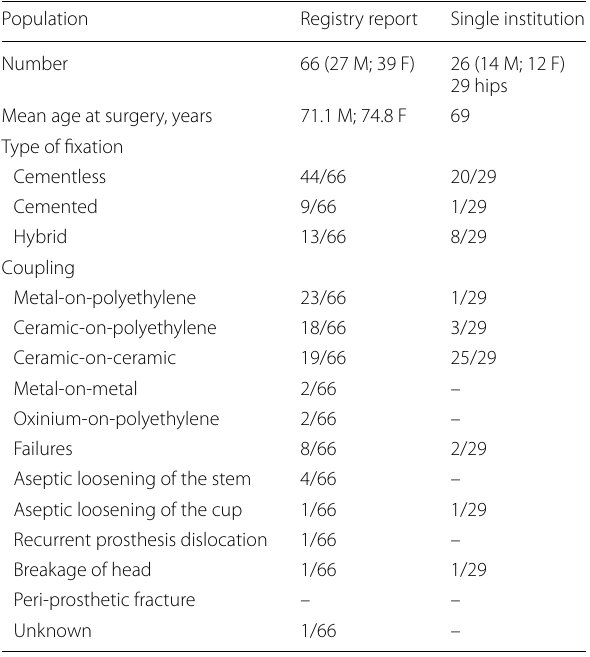
Table 1 Comparison between populations collected from